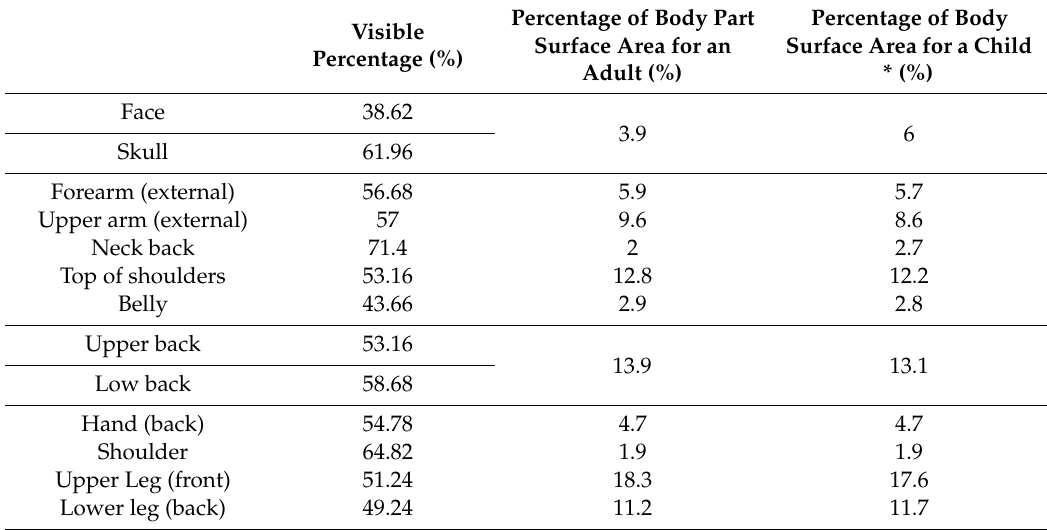
Table 1. Visible percentage and percentage of surface area for body